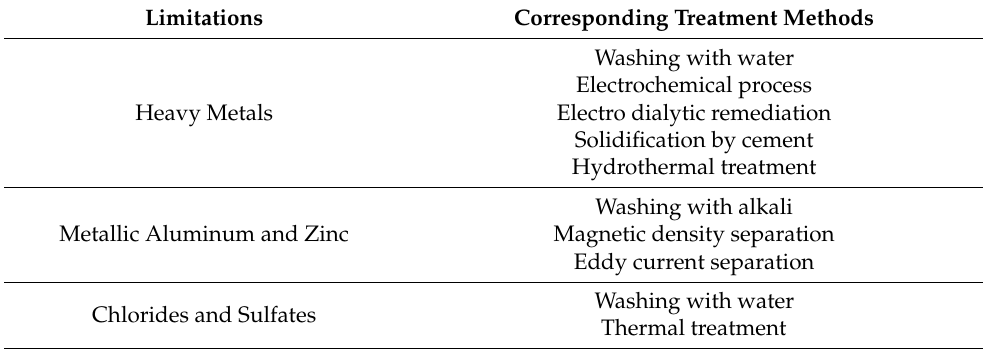
Table 3. Limitations and treatment methods of